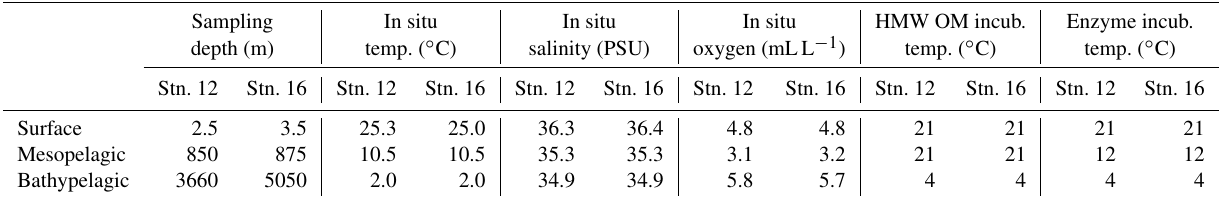
Table 1. Sampling depth, in situ characteristics, and incubation temperatures of water collected for mesocosms at each station and depth. OM: organic matter, PSU: practical salinity